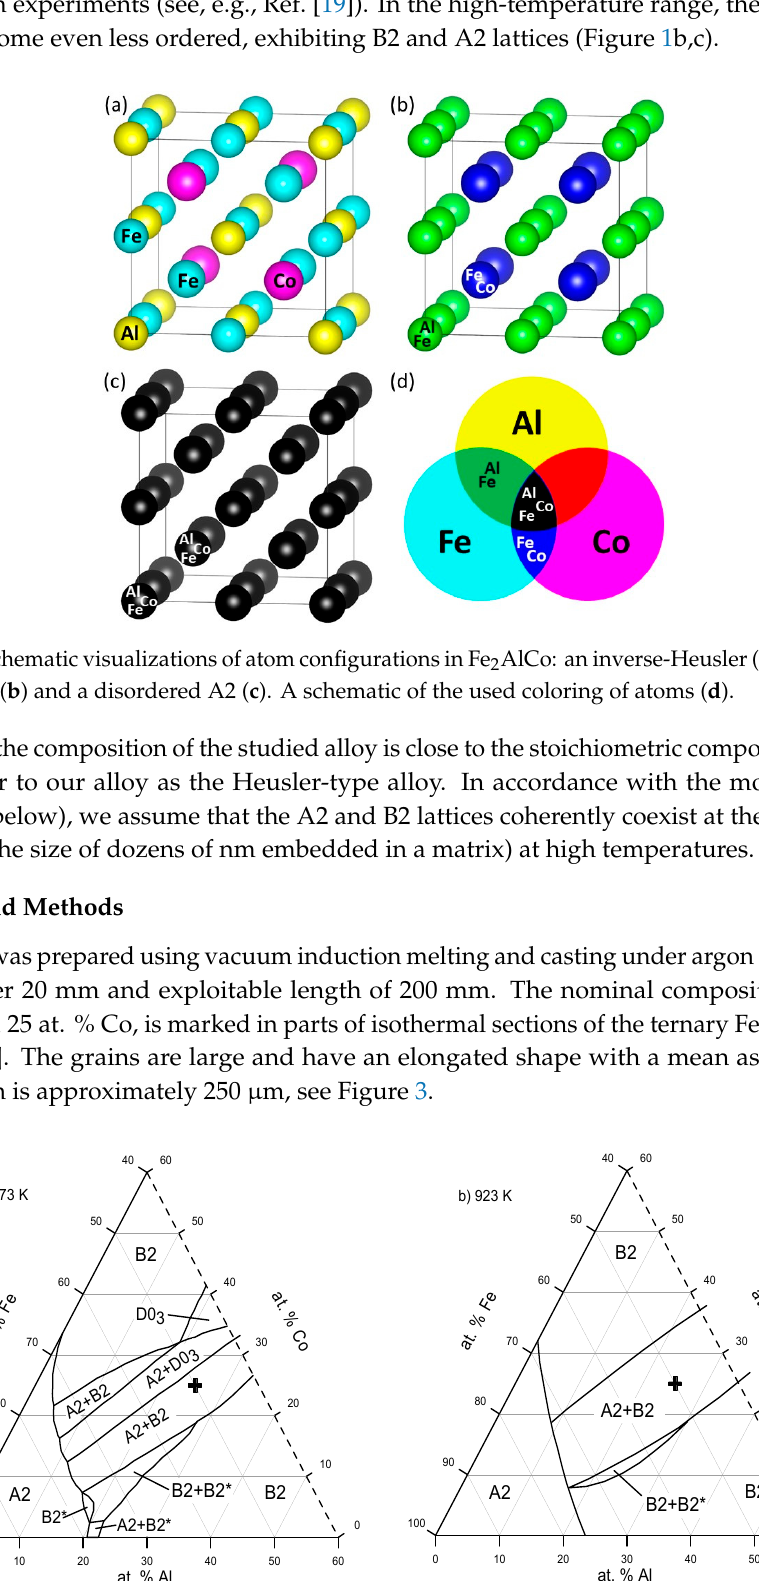
Figure 2. Details of the isothermal sections of the Fe–Al–Co system at ( a ) 873 K, calculated, and ( b ) 923 K, experimental, according to Kozakai et al. [20].